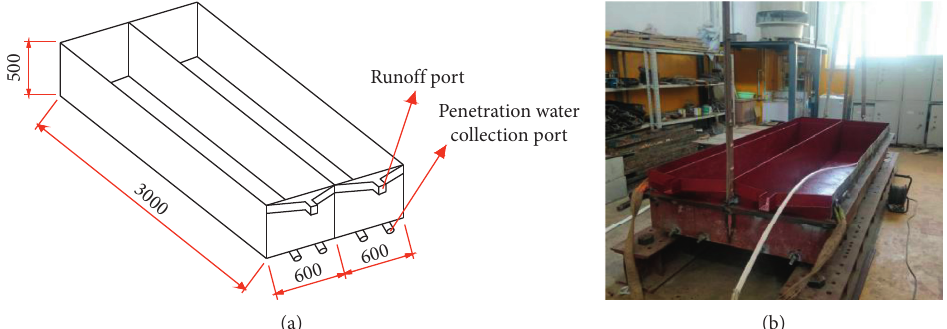
Figure 2: Modelling rig for simulating slope soil erosion treatment: (a) schematic; (b) forged